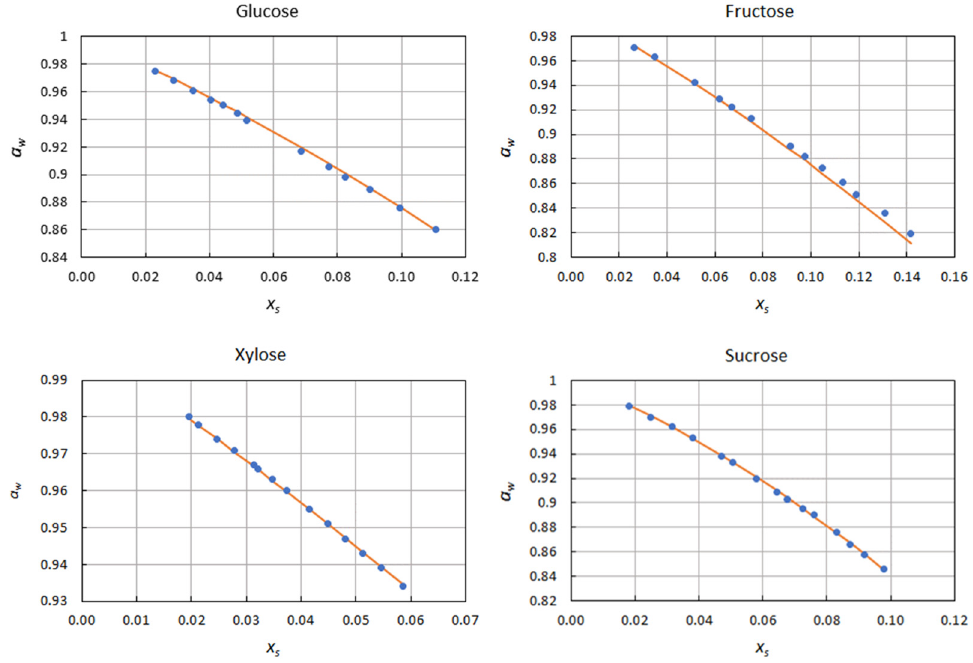
Figure 2. Water activity curves in the presence of sugars predicted by Equation (10), and comparison with the experimental data points.